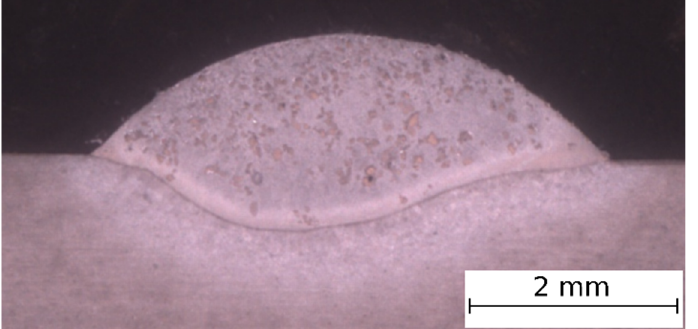
Figure 2. The macrograph of single-pass coating (40% TiC, laser beam power 2100 W, speed 0.25 m/min, powder feed rate 0.05 g/mm).